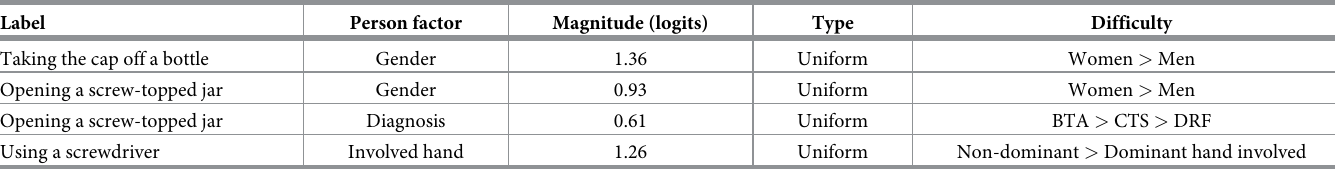
The ABILHAND-HS structure and targeting of HS patients are illustrated in Fig 2, show- ing an average patients’ manual ability of 1.17 logits (SD = 1.85 logits; i.e. 58 (15) cen- tiles). Twenty-four patients (7.9%) were able to perform all 23 activities easily, and were thus identified as extreme patients. Extreme patients tended to be younger men evaluated more than 6 months after treatment, and were more likely to have a CTS rather than a Table 3. Differential item functioning (DIF) summary.